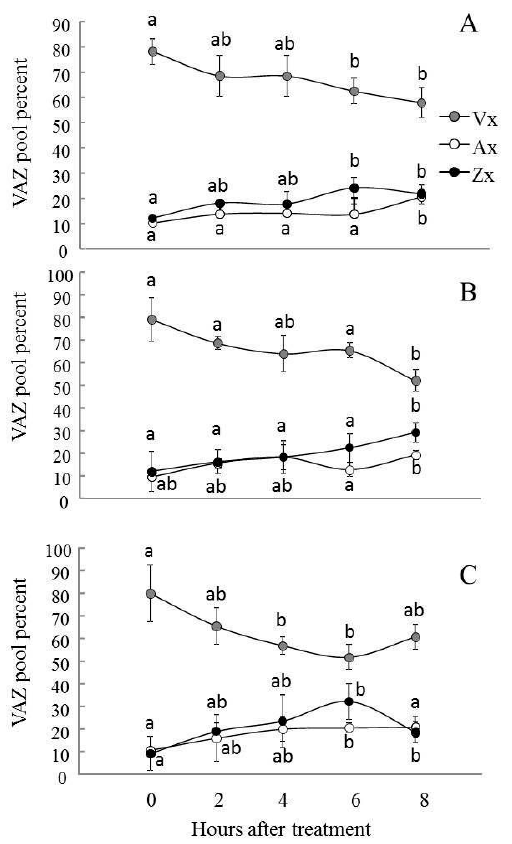
Figure 3. Relative percentage of xanthophyll cycle pigments (Vx, Ax, Zx) in leaves of WT ( A ), XX-2 ( B ), and AS-12 ( C ) Arabidopsis thaliana plants grown at 90 μ mol m − 2 s − 1 (0 h) and after 2–8 h of moderately high light (400 μ mol m − 2 s − 1 ). Vx—violaxanthin, Ax—anteraxanthin, Zx—zeaxanthin. Data are presented as mean ± SE of values from three independent experiments (for n = 3 for each experiment). Significant differences between mean values (ANOVA, Duncan’s test, p < 0.05) are indicated by different letters (a, b). The same or double letters (ab) indicate no significant differences between the means.